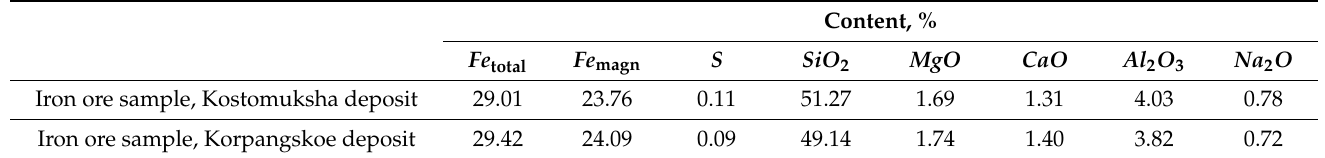
Table 1. Chemical composition of studied iron ore samples.